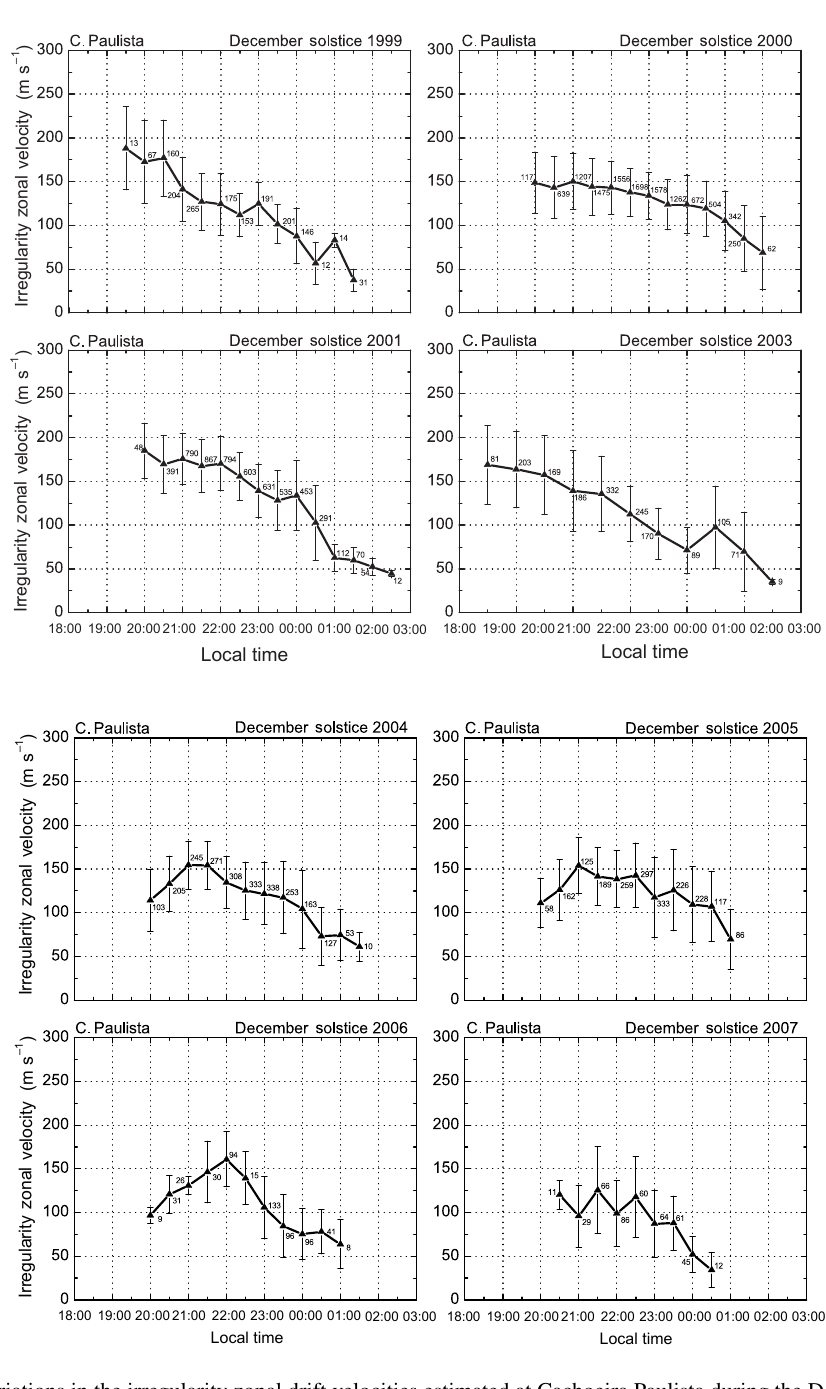
Figure 4. Nocturnal variations in the irregularity zonal drift velocities estimated at Cachoeira Paulista during the December solstice months of the years 1999–2001 and 2003–2007 (from top to bottom